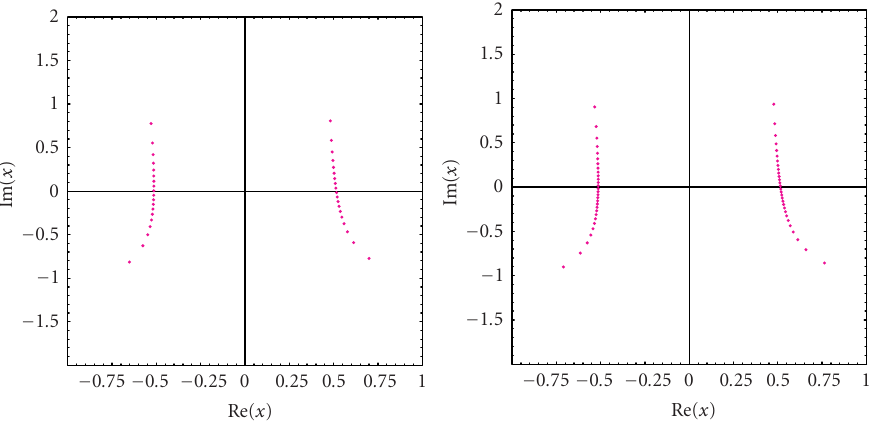
Figure 3.5. Zeros of q -Bernoulli polynomials β m ( x ,1 | − 11 / 10), m = 40,60, and x ∈ C